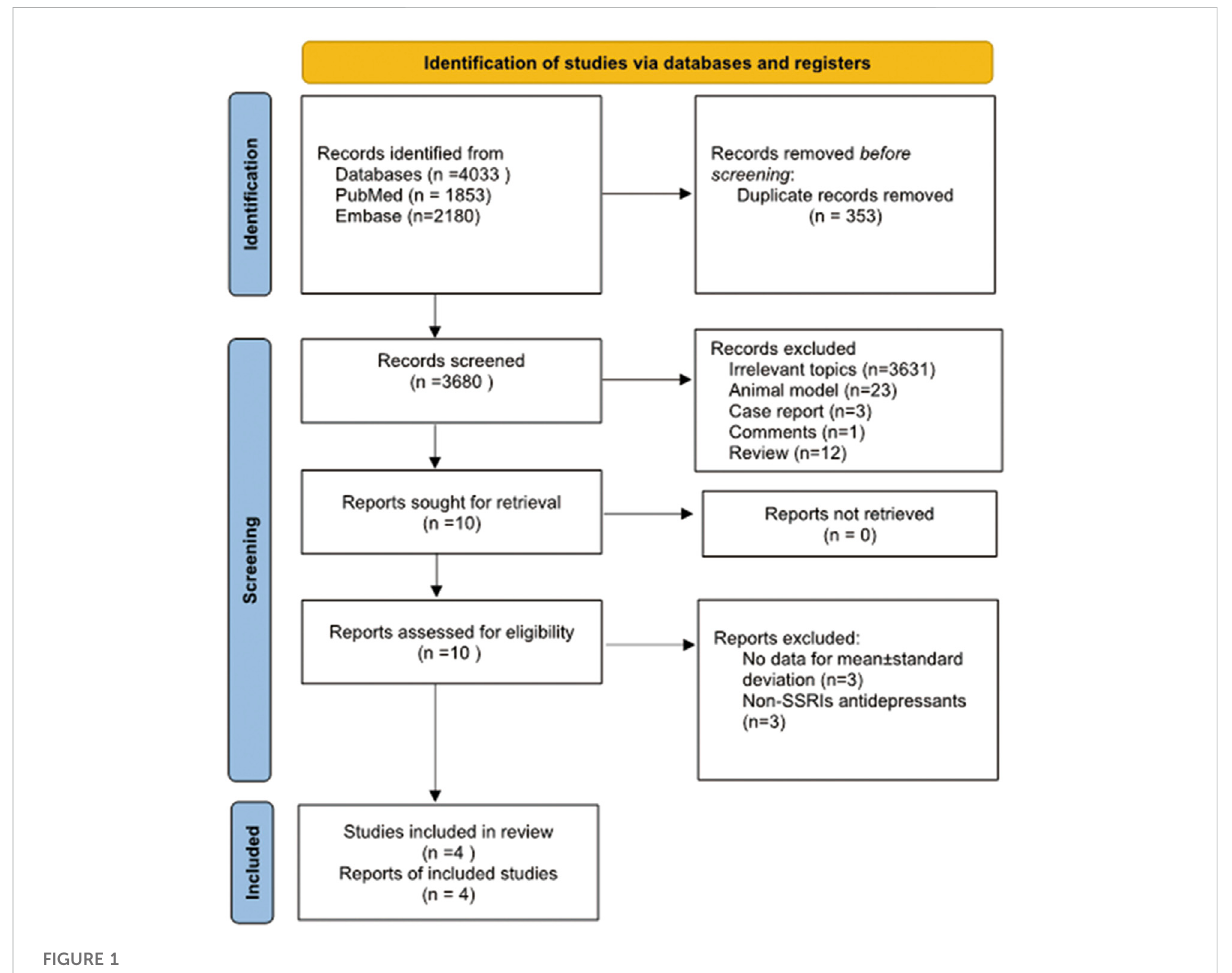
Articles search and screening process.